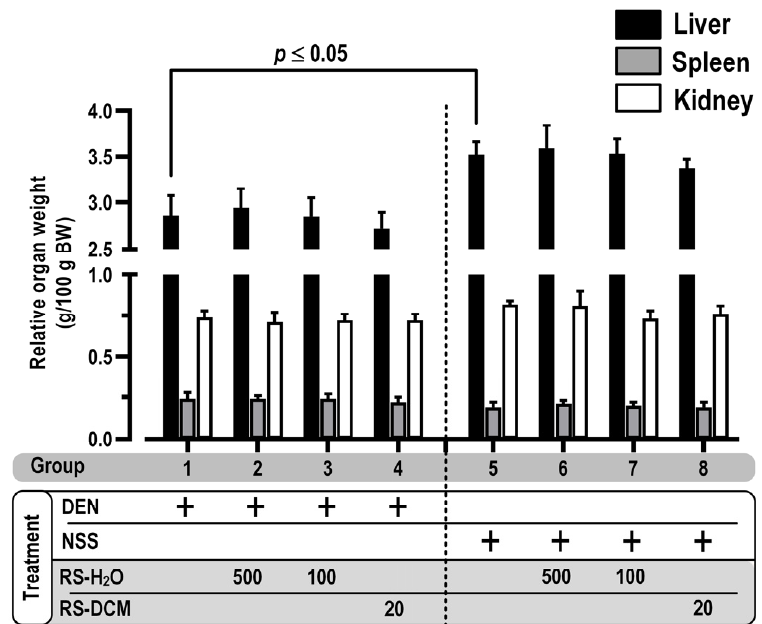
Figure 2. The effect of CP on relative vital organ weight. The values are expressed as mean ± SD. The data were distributed normally (Shapiro–Wilk: p > 0.05) and were analyzed for statistical significance using one-way ANOVA with LSD’s post hoc test. RS dosage unit is mg/kg BW.